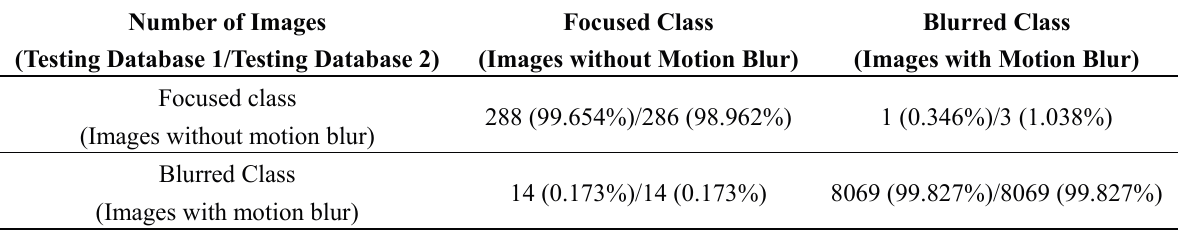
Table 4. Classification results of images into focused and blurred classes for two testing databases.